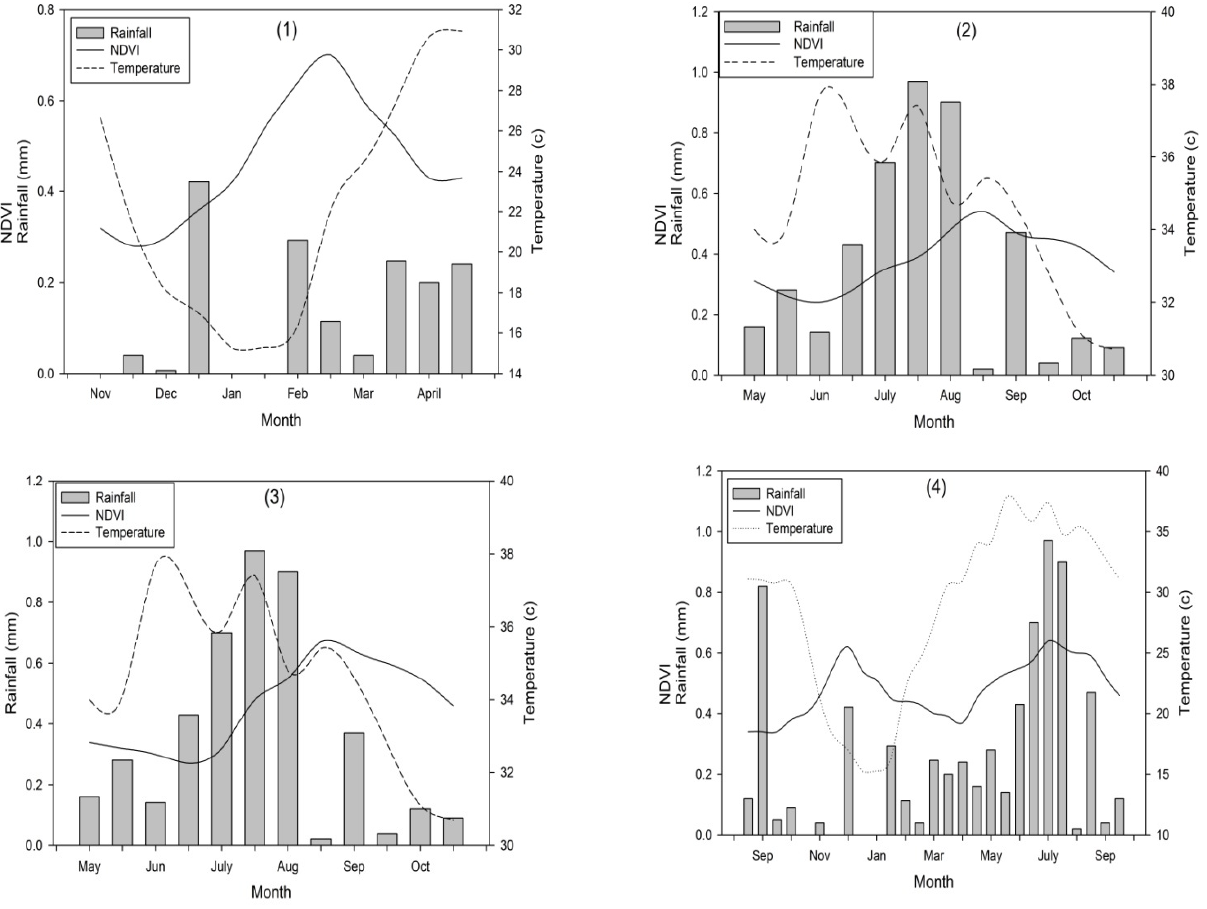
Figure 12. The trend of NDVI with rainfall and temperature is ( 1 ) wheat, ( 2 ) cotton, ( 3 ) rice, and ( 4 ) sugarcane.